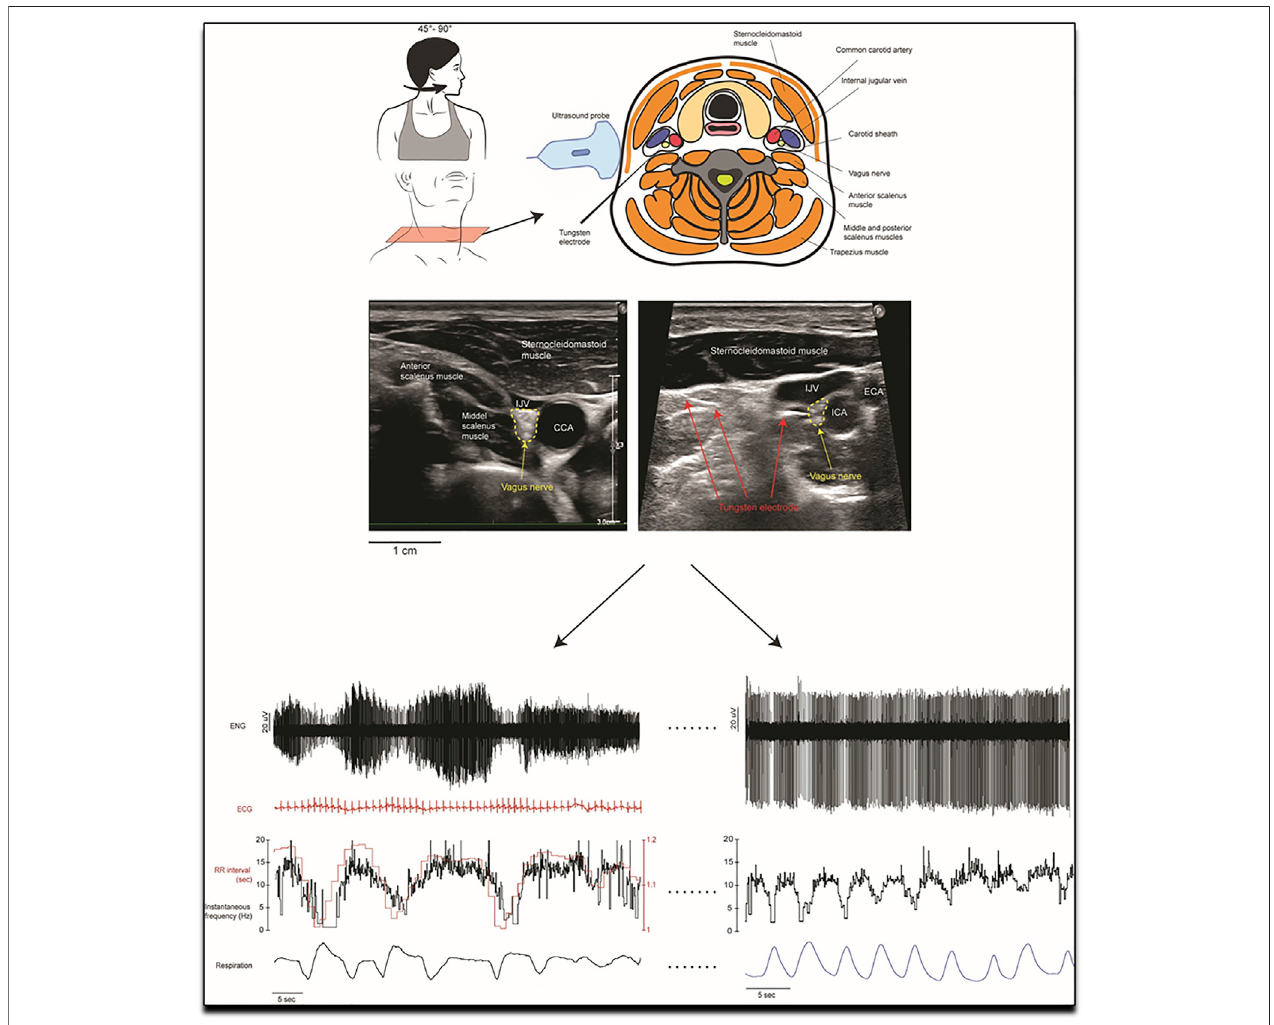
FIGURE 2 | Methodology of the fi rst in human invasive measurement of vagal nerve activity. A tungsten microelectrode is carefully and under ultrasound guidance placed inthe vagal nerve, where its activity canthen berecorded and analysed.Invasive measurement ofvagal nerveactivity have not been performed in COPD to date. Reproduced, with permission, from Ottaviani et al. (2020) (Ottaviani et al., 2020). Upper part of the fi gure: Schematic representation of the orientation of the head, the structures in the neck and the dorsolateral approach of the microelectrode as it is advanced manually towards the right vagus nerve. This approach avoided the carotid artery and jugular vein. The nerve is highlighted in the ultrasound images from two recording sessions which shows the common carotid artery (CCA), internal carotid artery (ICA), external carotid artery (ECA) and the internal jugular vein (IJV) and nearby muscles. The image on the right shows the microelectrode tip asit impales the vagus nerve. Lower part of the fi gure: Examples of microelectrode recordings from the left cervical vagus nerve in one participant. Lower left recording: The fi ring of the tonically active unit is covaried with cardiac interval. Variations in spike amplitude re fl ect slight movements of the microelectrode with neck movements. Superimposed spikes con fi rm that this was a single-unit recording. Lower right recording: a tonically fi ring axon, the fi ring rate of which decreased during inspiration.